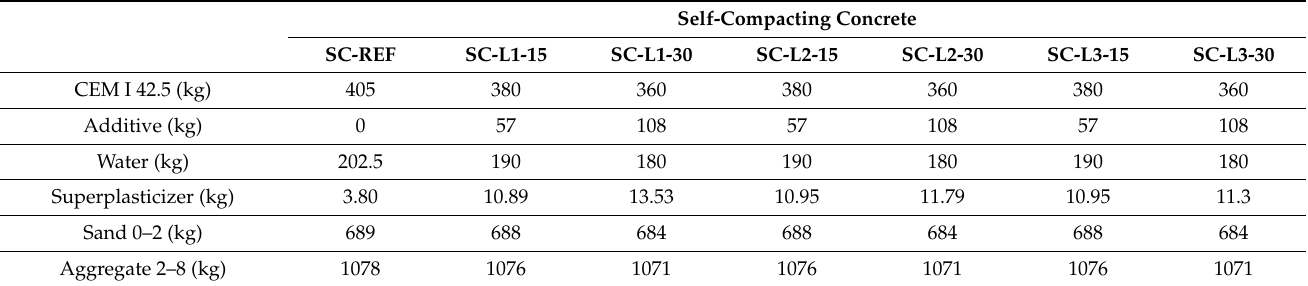
Table 4. Composition of 1 m 3 of self-compacting concrete without air-entraining admixture.